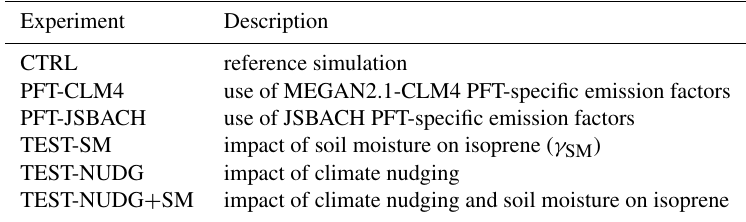
Table 3. List of simulations performed.